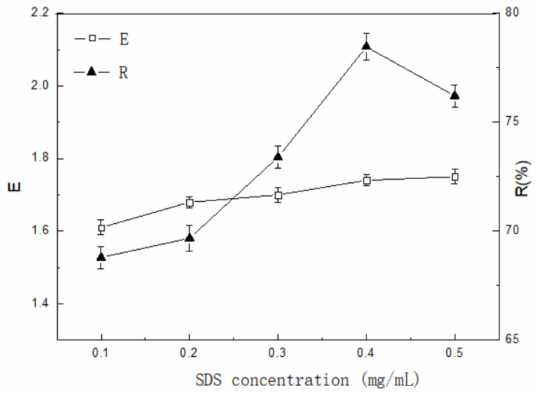
Figure 6. Effects of concentration of SDS on enrichment ratio and